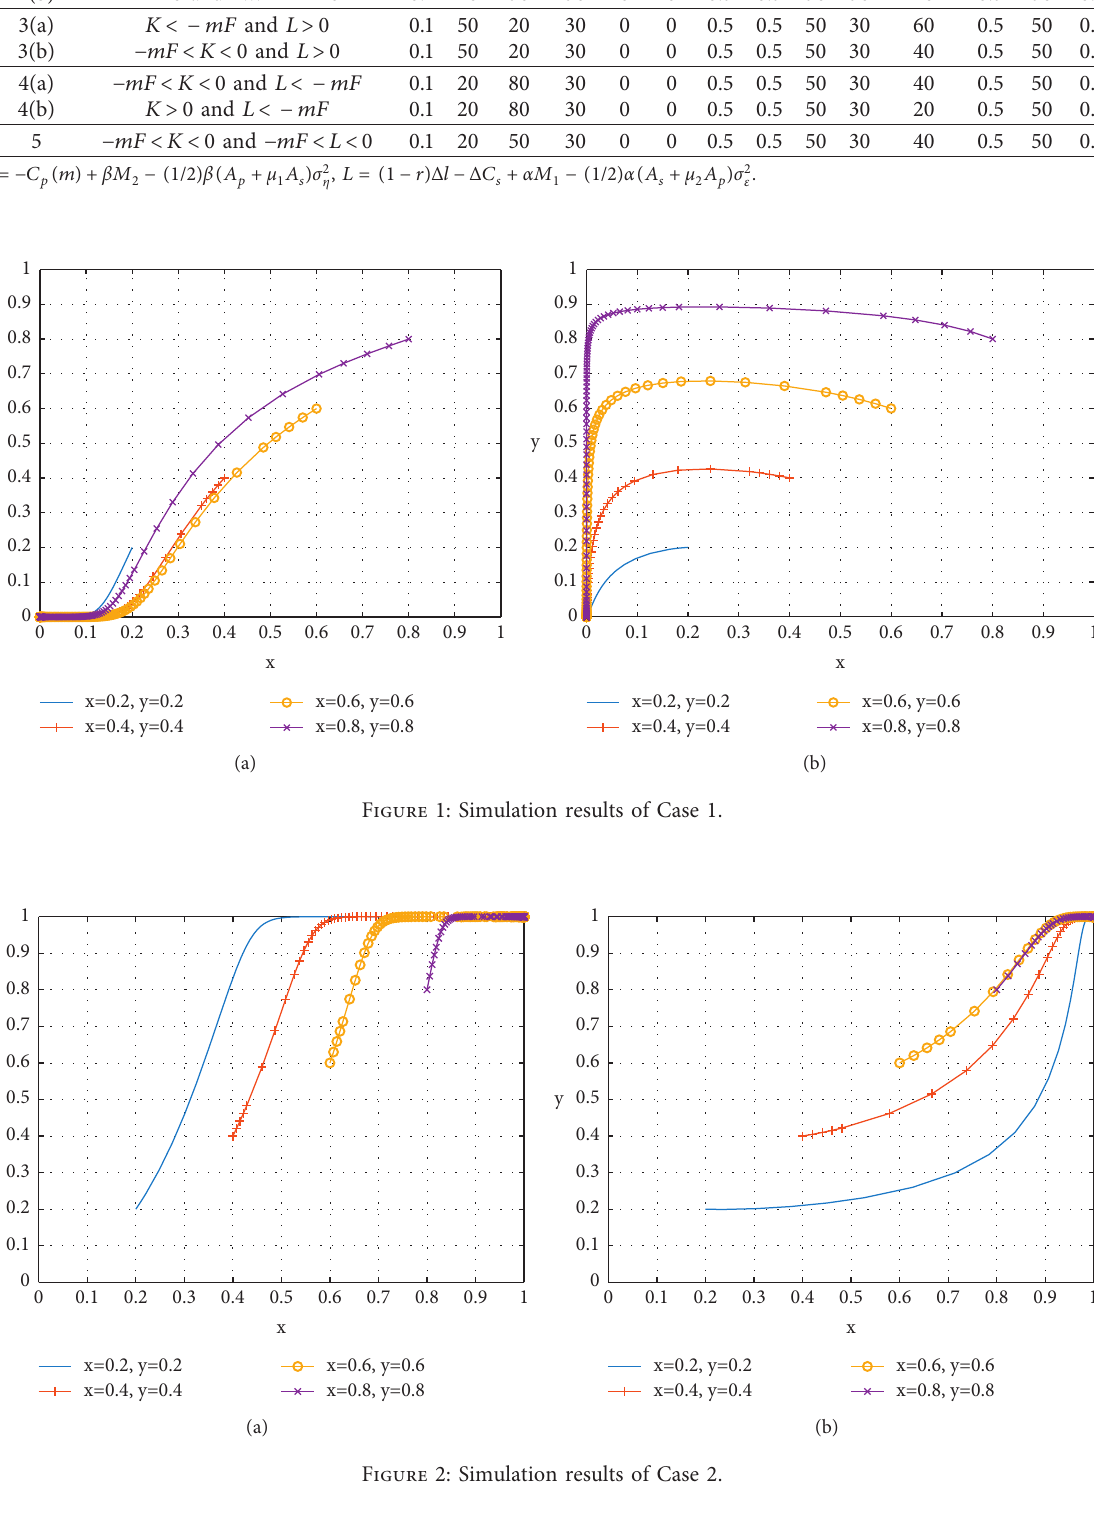
Figure 2: Simulation results of Case